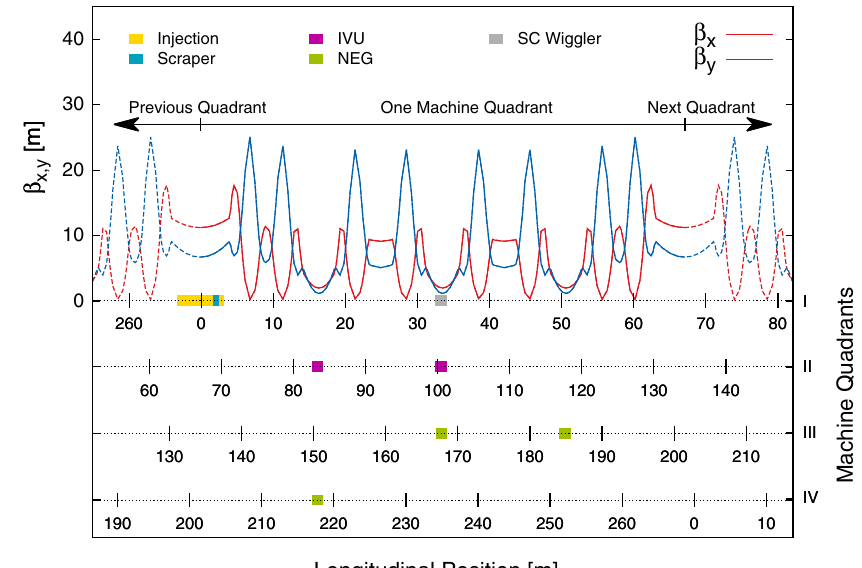
FIG. 1. Betatron functions and location of the major transverse impedance sources in the ALBA storage ring. The ring nominal lattice has a fourfold symmetry, where each quadrant is composed by two Chasman-Green cells surrounded by two matching cells. The injection section is between two matching cells where the vertical betatron function reaches higher